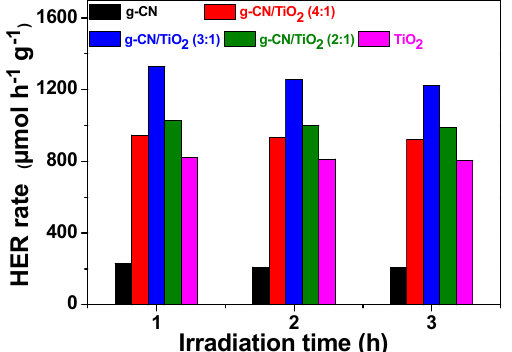
Figure 11. Photocatalytic hydrogen production rates after 1, 2, and 3 h illumination of g-CN, TiO 2 , and g-CN / TiO 2 catalysts associated to the NiS cocatalyst (1.5 wt.%) using a 300 W Xe lamp as irradiation source and water containing 10 vol.% glycerol as sacrificial substrate.